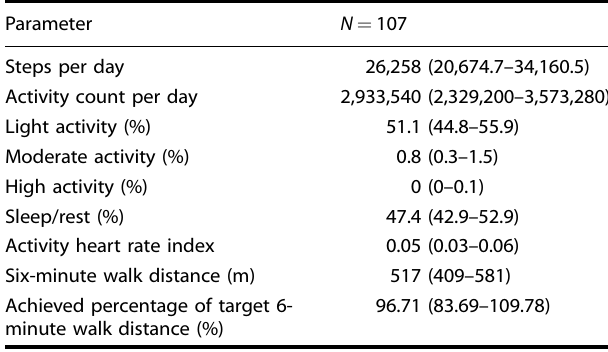
Table 2. Parameters of activity.